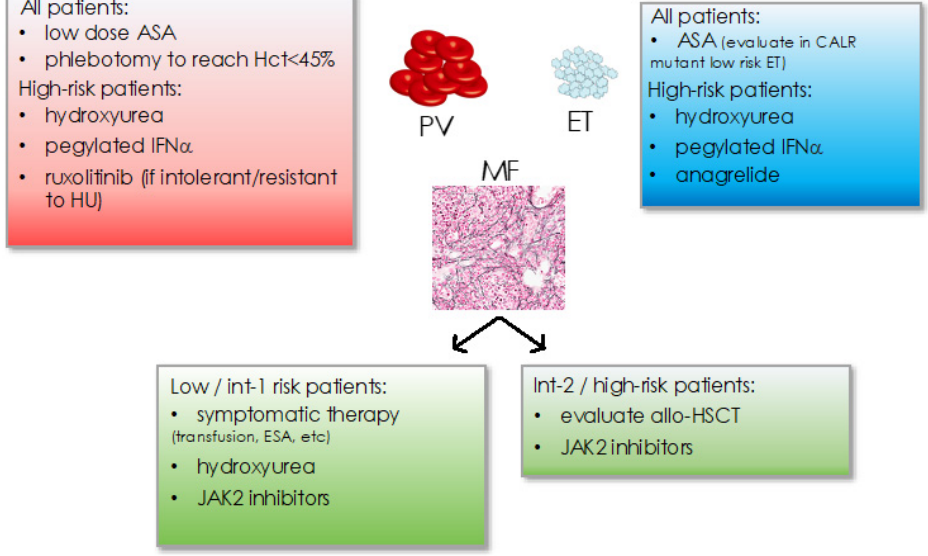
Figure 3. Current treatment recommendations in MPN for PV, ET, and MF subtypes. Hct: hematocrit, ASA: acetyl-salicylic acid, IFN α : interferon-alpha, int: intemediate, ESA: erythropoiesis stimulating agents, allo-HSCT: allogeneic hematopoietic stem cell transplantation.